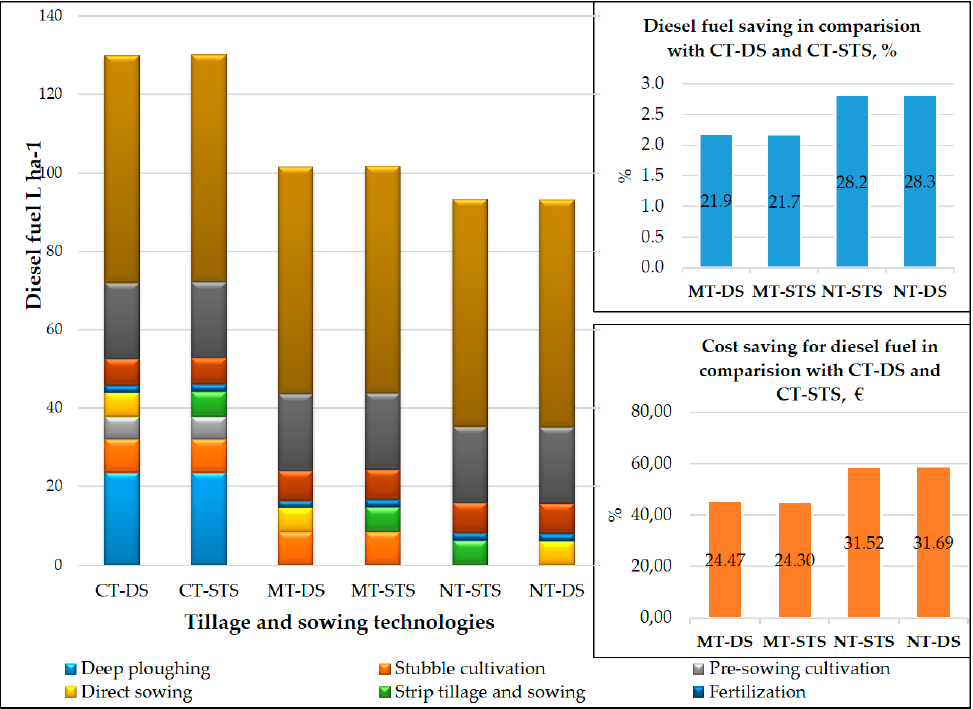
Figure 3. Contribution of different inputs to diesel fuel consumption and saving compared to CT technology.